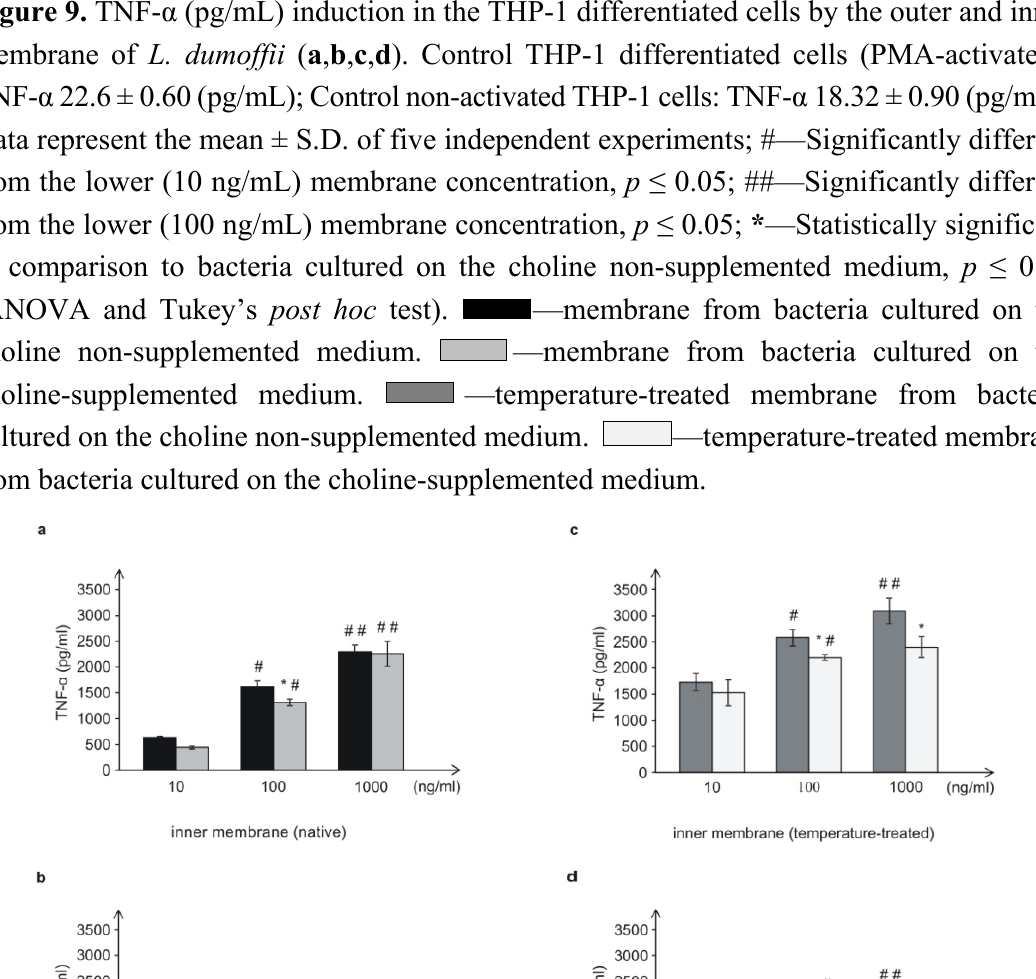
Figure 9. TNF- α (pg/mL) induction in the THP-1 differentiated cells by the outer and inner membrane of L. dumoffii ( a , b , c , d ). Control THP-1 differentiated cells (PMA-activated): TNF- α 22.6 ± 0.60 (pg/mL); Control non-activated THP-1 cells: TNF- α 18.32 ± 0.90